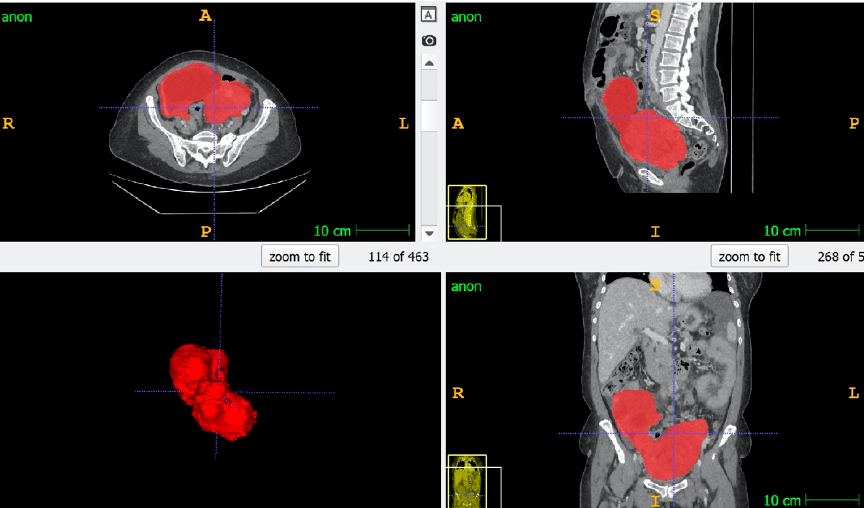
Figure 1. An example of segmentation of tumor volume using ITKsnap.